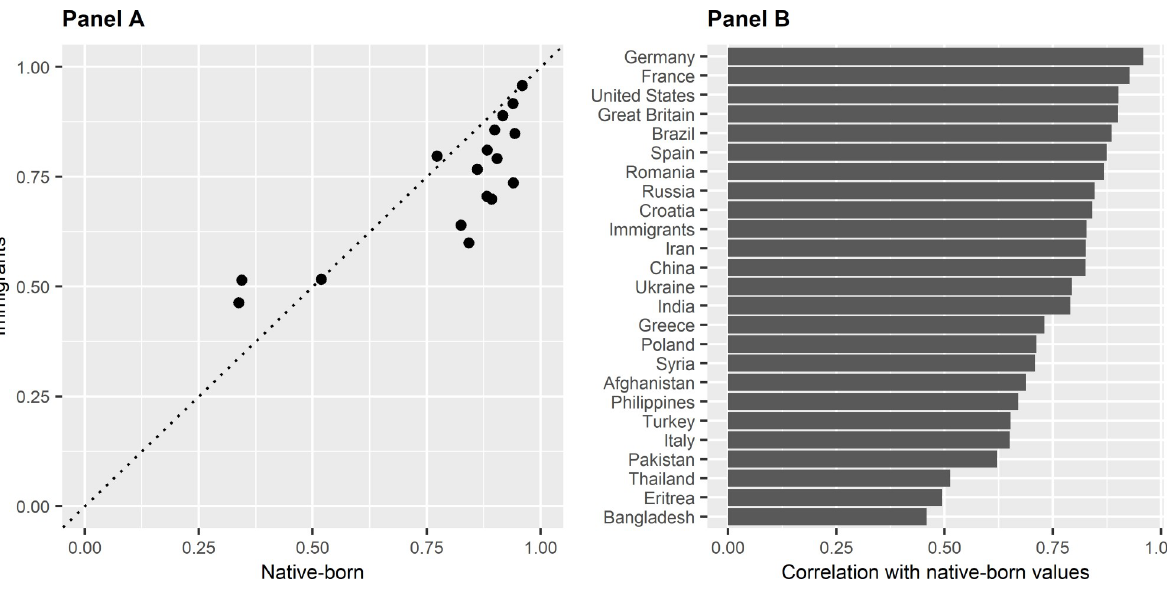
Fig 3. Correlation of social values between immigrants and